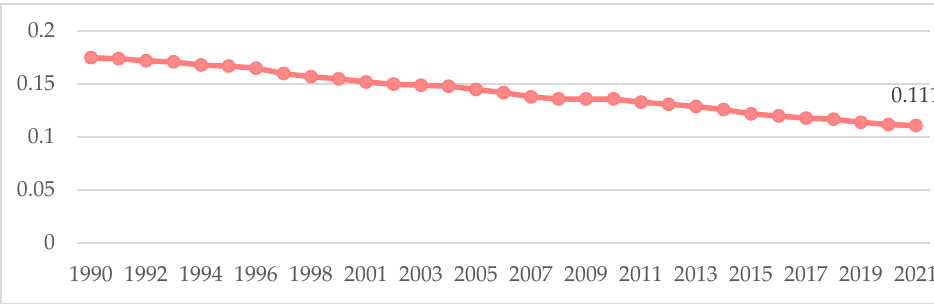
Figure 9. Energy intensity in the world, according to data for 1990–2021, koe/$15p [30].